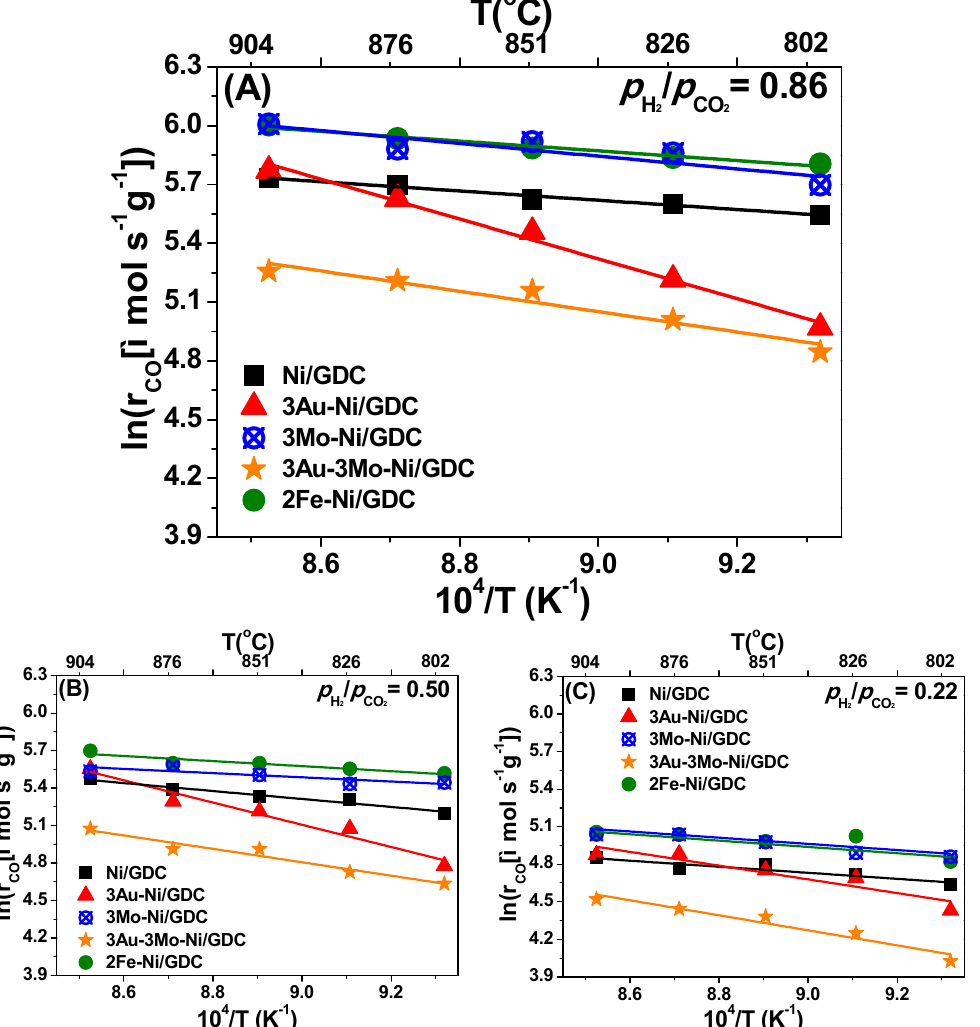
Figure 6. Arrhenius plots of the CO production rates ( μ mol s − 1 g − 1 ) on ESCs comprising: Ni/GDC, 3Au-Ni/GDC, 3Mo-Ni/GDC, 3Au–3Mo-Ni/GDC, and 2Fe-Ni/GDC, in the range of 800–900 ◦ C, under three different mixtures: ( A ) 24.5% H 2 O - 24.5% CO 2 - 21% H 2 (P H2 /P CO2 = 0.86), ( B ) 28% H 2 O - 28% CO 2 - 14% H 2 (P H2 /P CO2 = 0.50), and ( C ) 31.5% H 2 O - 31.5% CO 2 - 7% H 2 (P H2 /P CO2 = 0.22). Dilution of He: 30 vol.% and F total = 140 cm 3 /min (at STP conditions: 0 °C, 1 atm) in all cases. Table 3. Apparent activation energies (E a,app , kJ/mol) for the RWGS reaction on ESCs for three different